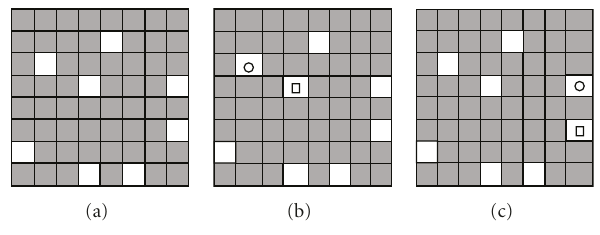
Figure 2: (a) Maxima map of Figure 1(b) shown with shades where the brighter boxes represent the location of the maxima points, (b) and (c) sample maxima point and its nearest neighbor shown, respectively, with “ (cid:2) ” and “ (cid:3)